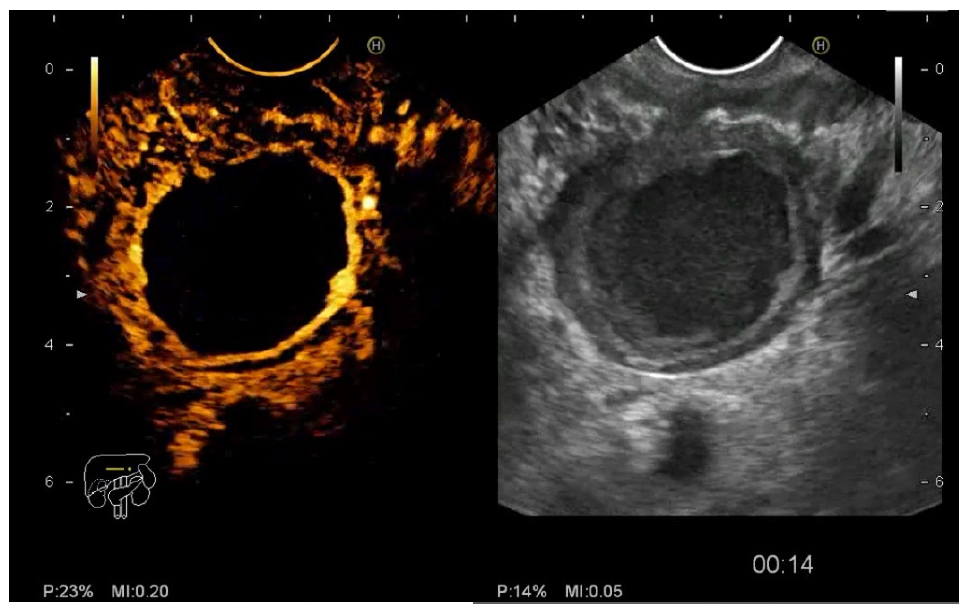
Figure 7. Contrast enhancement of the cystic wall.